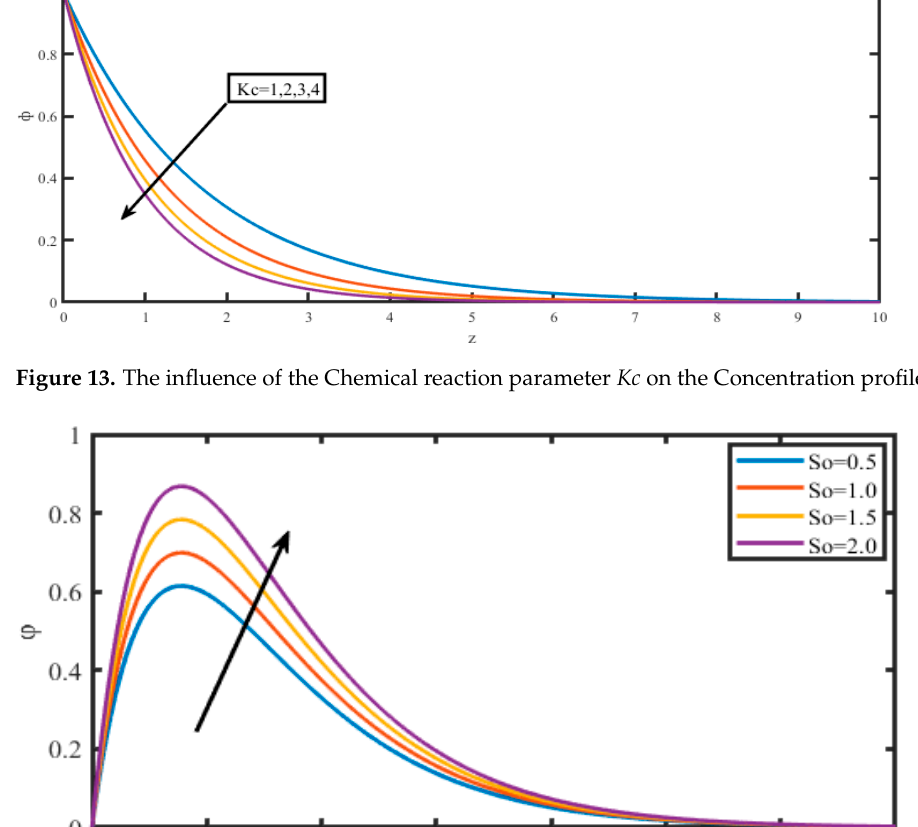
Figure 12. The influence of the Heat source parameter H on the temperature profiles.